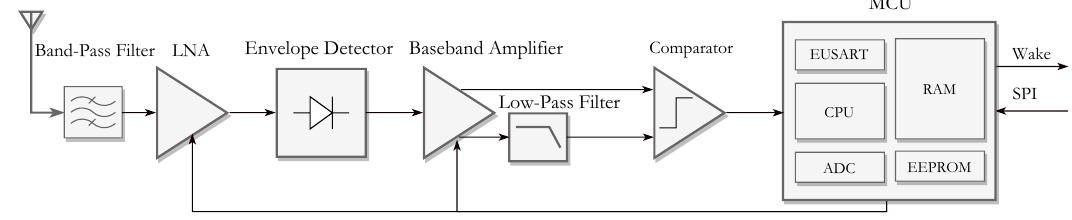
Figure 4. Block diagram of the proposed